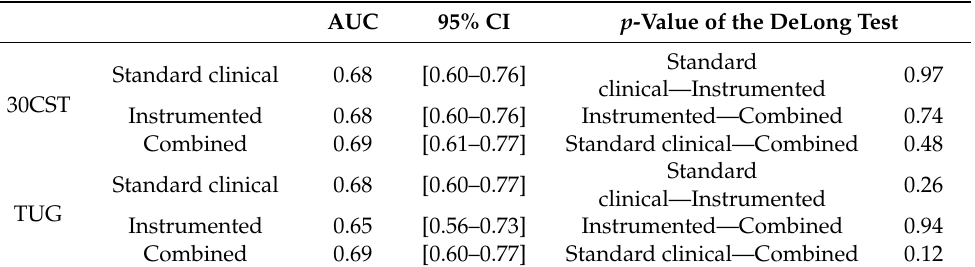
Figure 2. Discriminative ability (AUC and DeLong test) of standard clinical (black line), instrumented (blue line), and combined (red line) measures of the 30CST and TUG test. Table 4. Sensitivity